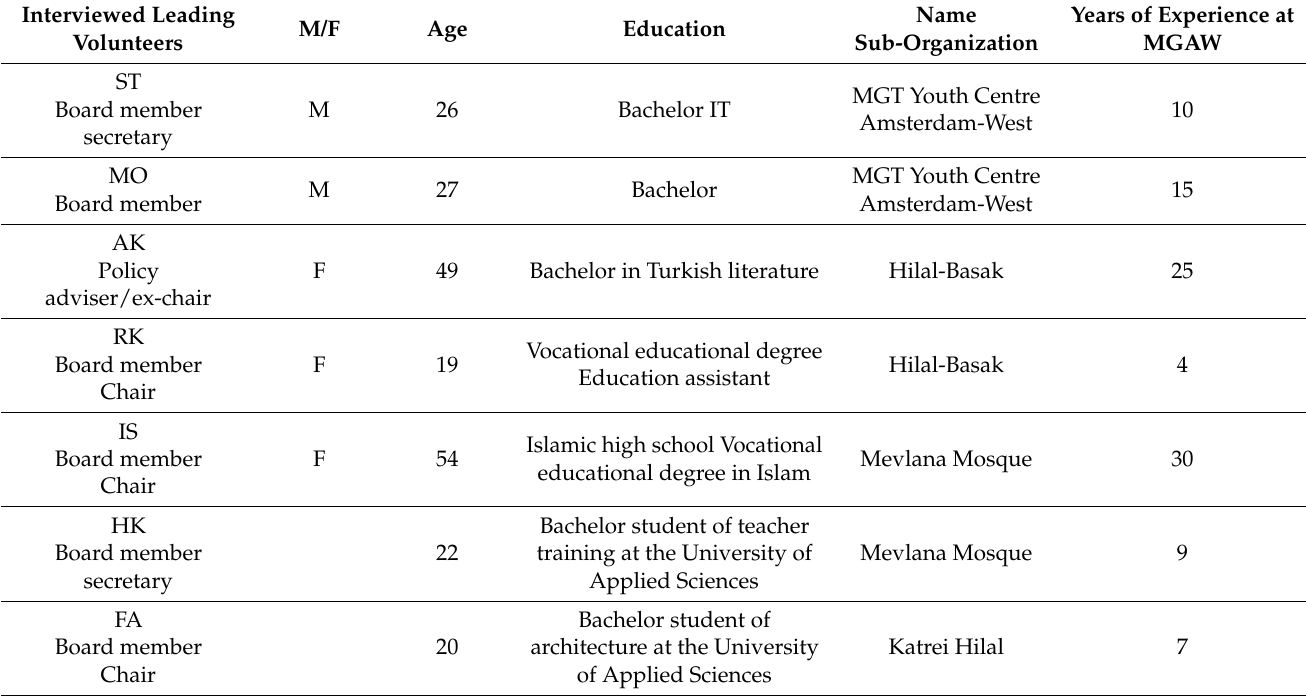
Table 1. Characteristics of the interviewed leading volunteers of